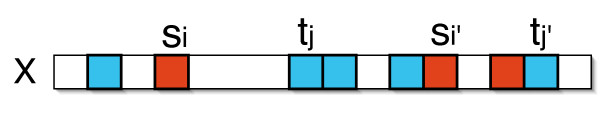
Overlapping. The red subsequence is overlapping with the blue subsequence in x. The indices (si, si') and (tj, tj') are alternating in x.